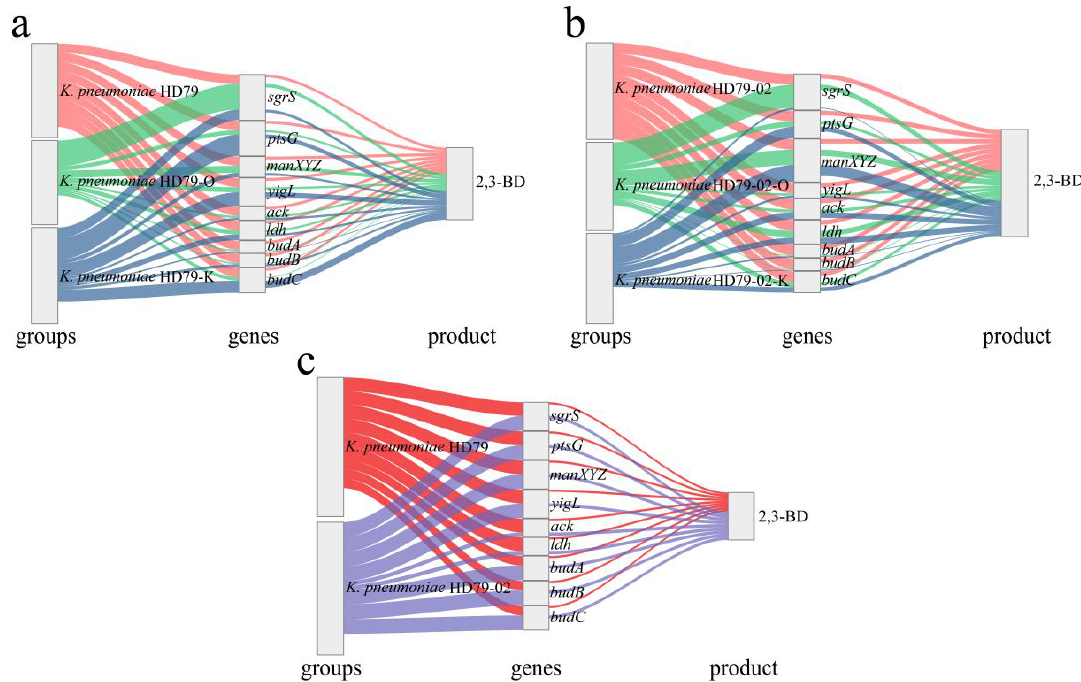
Figure 7. The distribution of carbon metabolism flow of each strain consuming glucose to produce 2,3-BD at 72 h of fermentation. A small cell in a Sankey diagram represents the amount of traffic allocated. The first column on the left describes the carbon flow allocated to each strain to represent glucose utilization, the second column describes the expression level of different genes in each strain, and the third column describes the carbon flow allocated to different strains to redistribute to the pathway producing 2,3-BD. ( a ) shows the K. pneumoniae HD79 series strains; ( b ) shows the K. pneumoniae HD79-02 series strains; ( c ) shows the K. pneumoniae HD79 strain and K. pneumoniae HD79-02 strain.